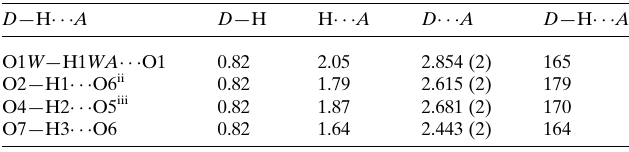
Table 2 Hydrogen-bond geometry (A˚ , (cid:5)